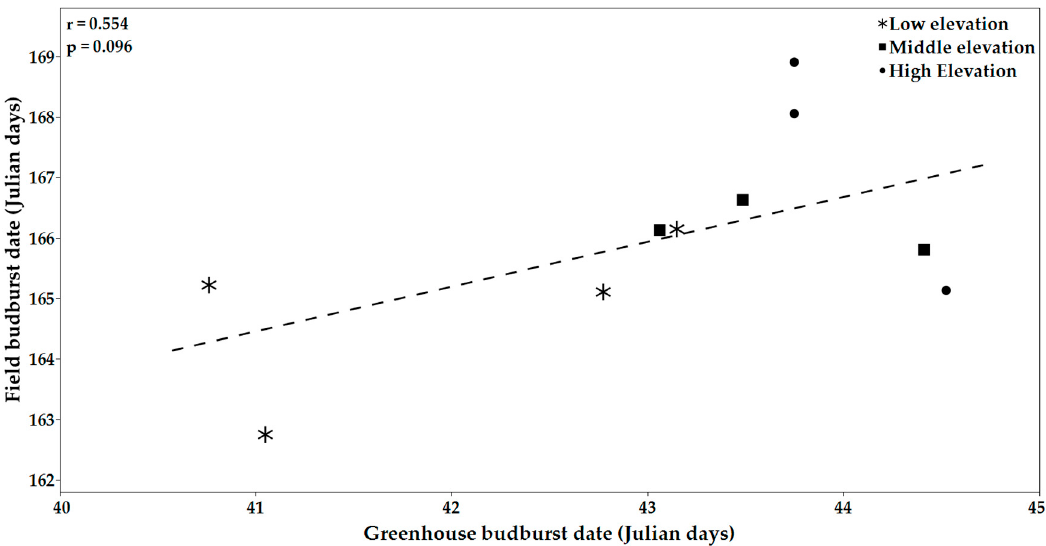
Figure 3. Relationships between mean budburst date measured under greenhouse and field conditions for the same provenances ( n = 10).